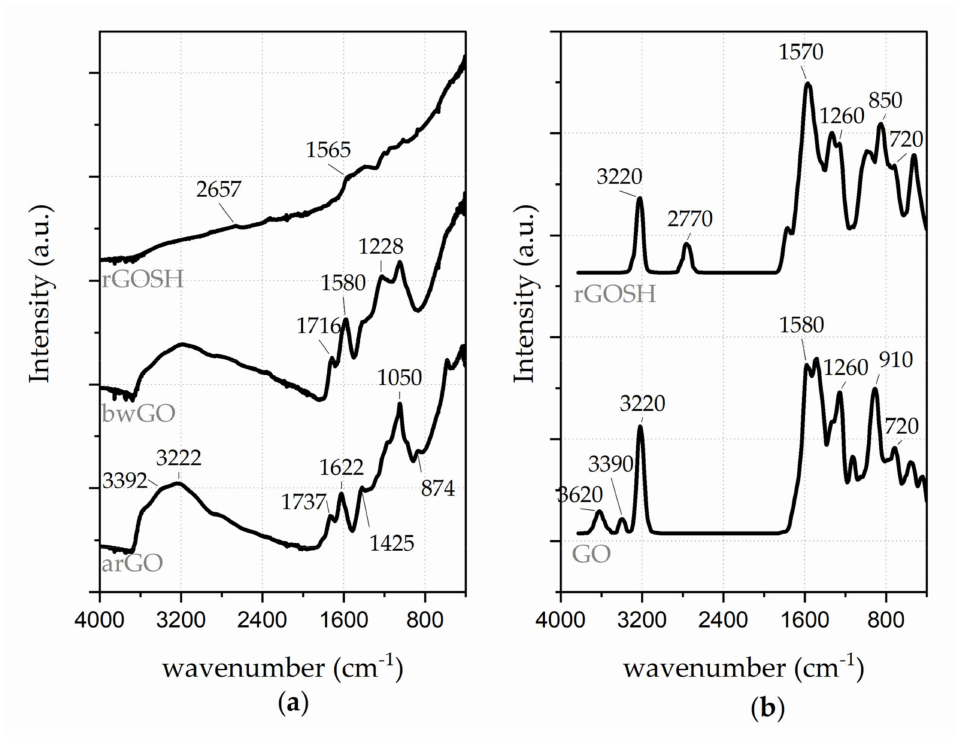
Figure 3. Infrared spectra of rGOSH in the comparison with GO: ( a ) Experimental attenuated total reflection-FTIR (ATR-FTIR) spectra of pristine GO, base-washed GO, and thiolated reduced GO; ( b ) calculated IR spectra of GO and thiolated reduced